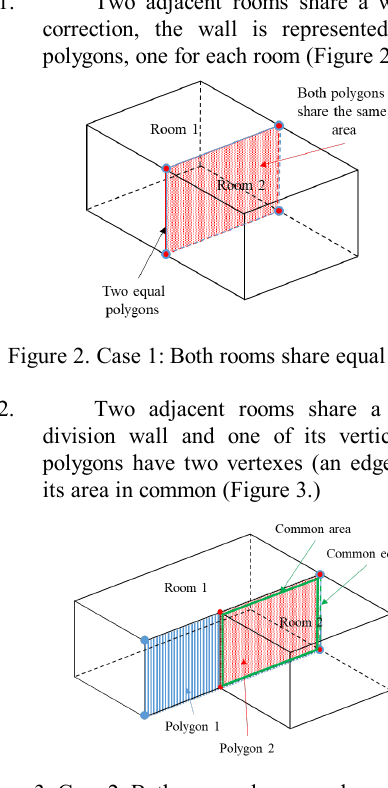
correction, the wall is represented as two equal polygons, one for each room (Figure 2).